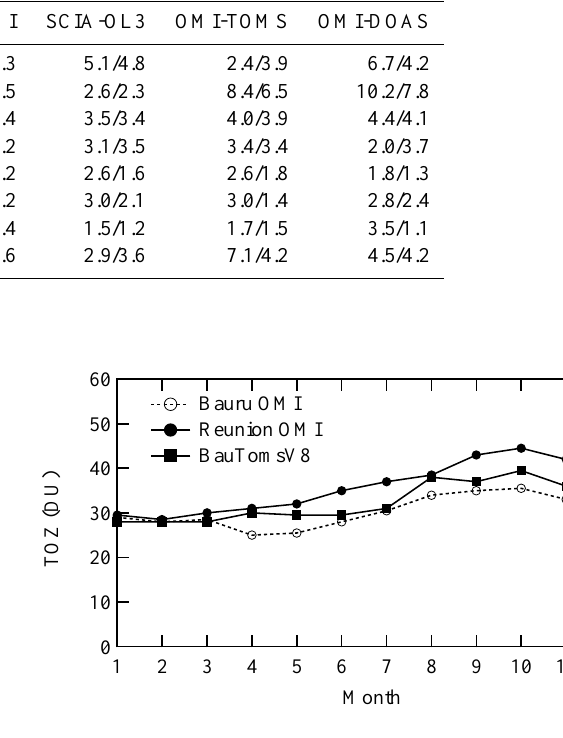
Fig. 16. Tropospheric ozone column derived from OMI in Bauru (open circles) and Reunion (filled circles) and TV8 climatology (filled